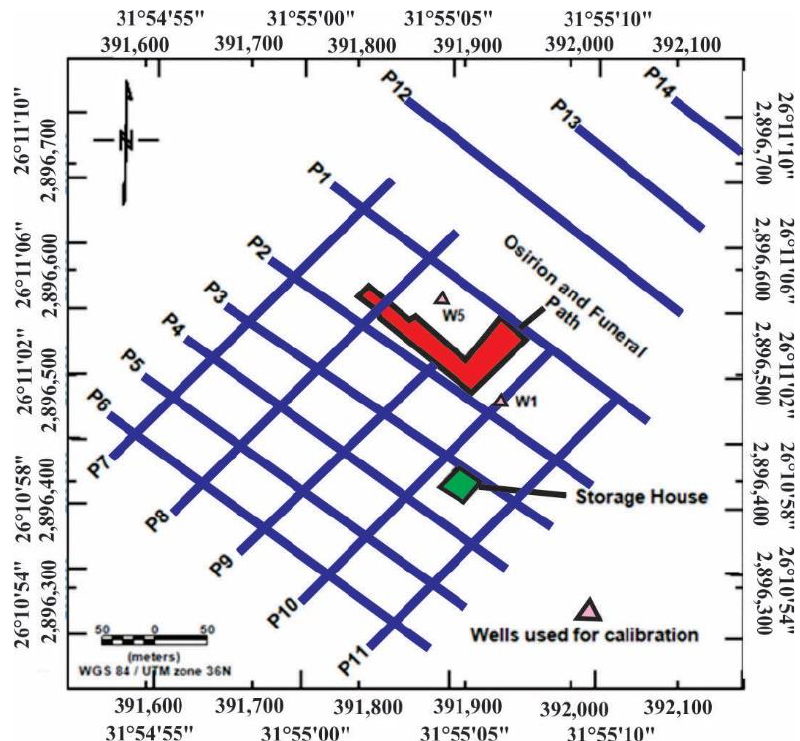
Figure 9. Map indexing the 14 ERT lines that were represented at the intended site during the survey utilizing 2D electrical resistivity tomography. Additionally, two accessible borehole locations are displayed. are